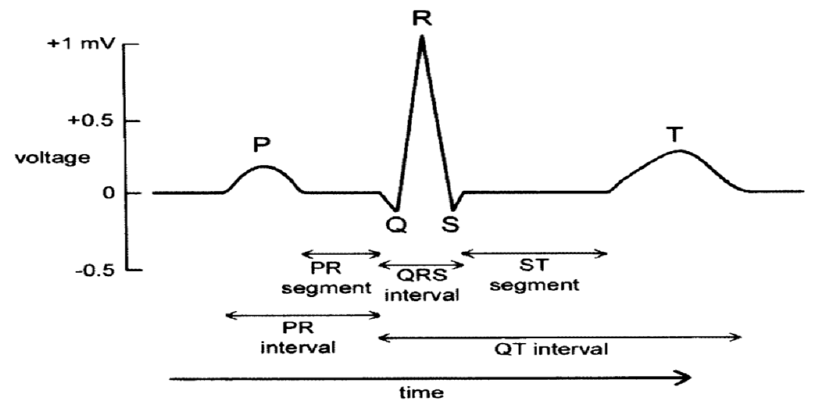
Figure 3. A typical ECG waveform for one cardiac cycle measured from the lead II position. The depolarization process of the cardiac cycle is initiated by the firing of the sinoatrial node in the right atrium of the heart. The atria then depolarizes, causing the P wave to be produced. The P wave occurs in the interval of 80–100 ms. As the P wave terminates, this indicates the complete depolarization of the atria, and following which, there is a con- traction. The contraction then causes action potentials to spread across the atrioventricular node. Then, the left and right ventricles start to depolarize, leading to the production of the QRS complex. This represents the commencement of ventricular contraction and the end of the atrial contraction. After the contraction the signal falls to the baseline, and the ventricles begin to repolarize after contraction, leading to the emergence of the T wave. This process is continuously repeated in the next cycle of the